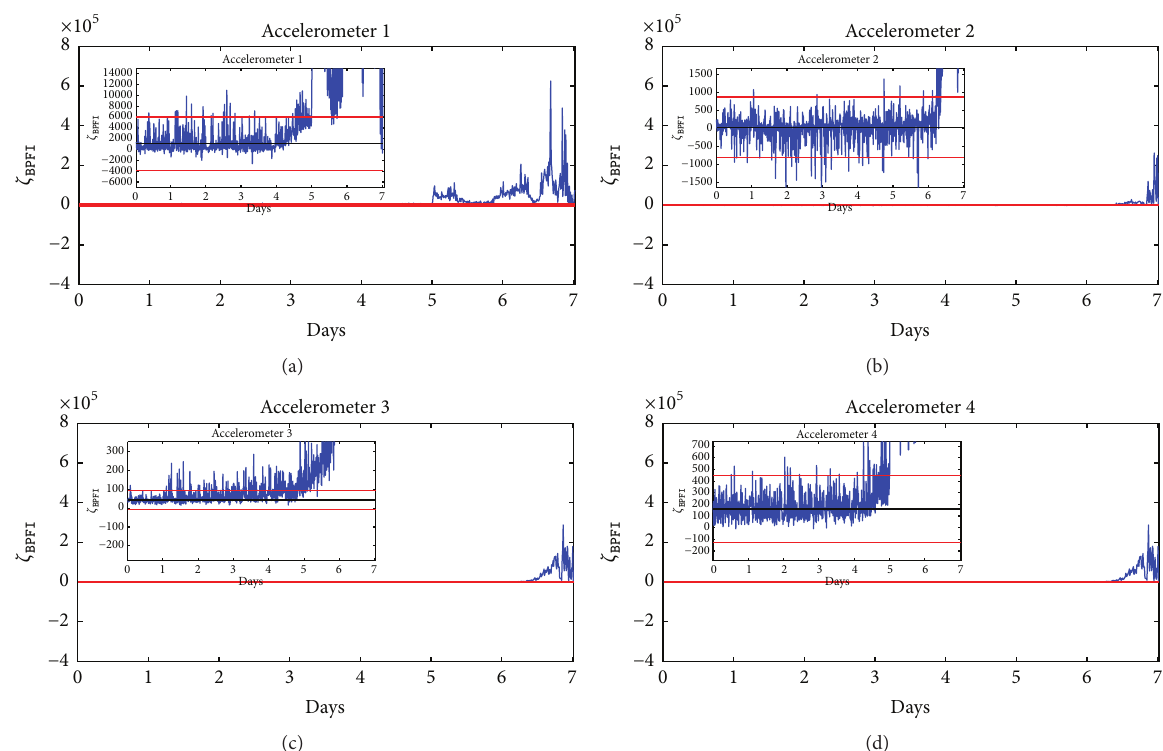
Figure 10: Damage indicators associated with the BPFI frequency from each accelerometer.